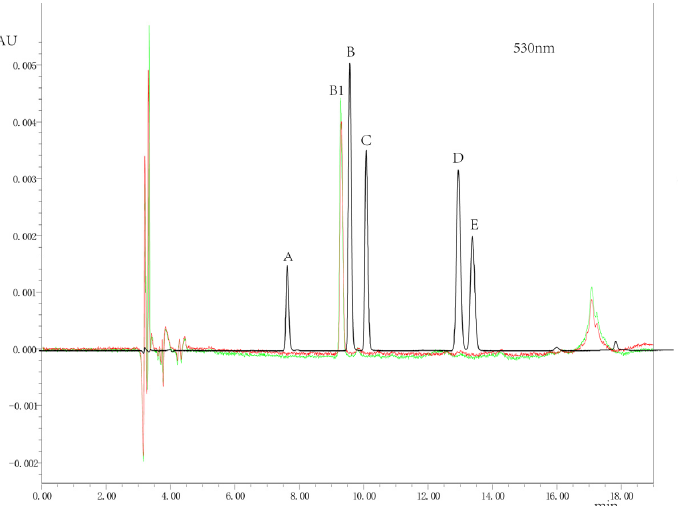
Figure 2. The concentrations of anthocyanin-related compounds in the flower buds of oriental lily ‘Siberia’. High-performance liquid chromatography-mass spectrometry (HPLC-MS) chromatograms suggested the presence of anthocyanin aglycones was completed at 530nm; the compounds were identified by comparing with the mass spectra of the standards. A—delphinidin, B/B1—cyanidin, C—petunidin, D—pelargonin, E—mallow pigment. Black color represents the standard, and red or green represents the text sample. Genes 2023 , 14 , x FOR PEER REVIEW